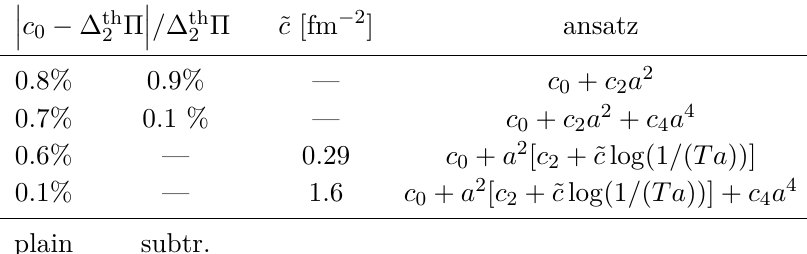
Table 6 . Accuracy of the continuum extrapolation of the thermal quantity ∆ th measured against the correct continuum value. The label “plain” refers to fitting the plain lattice observable, while for the case “subtr.” the logarithmic lattice artifact is subtracted as ∆ th Π ( Q 2 ; T ) − ˜ c ∆ a 2 log(1 / ( Ta )) . For the choice of scales made here T = 246 . 25 MeV, 2 2 Π ’ 2 . 2 fm − 2 (see eq. (E.3)). The lattice data and the fit Q = 8 πT ’ 6 . 2 GeV, we have ˜ c ∆ 2 Π